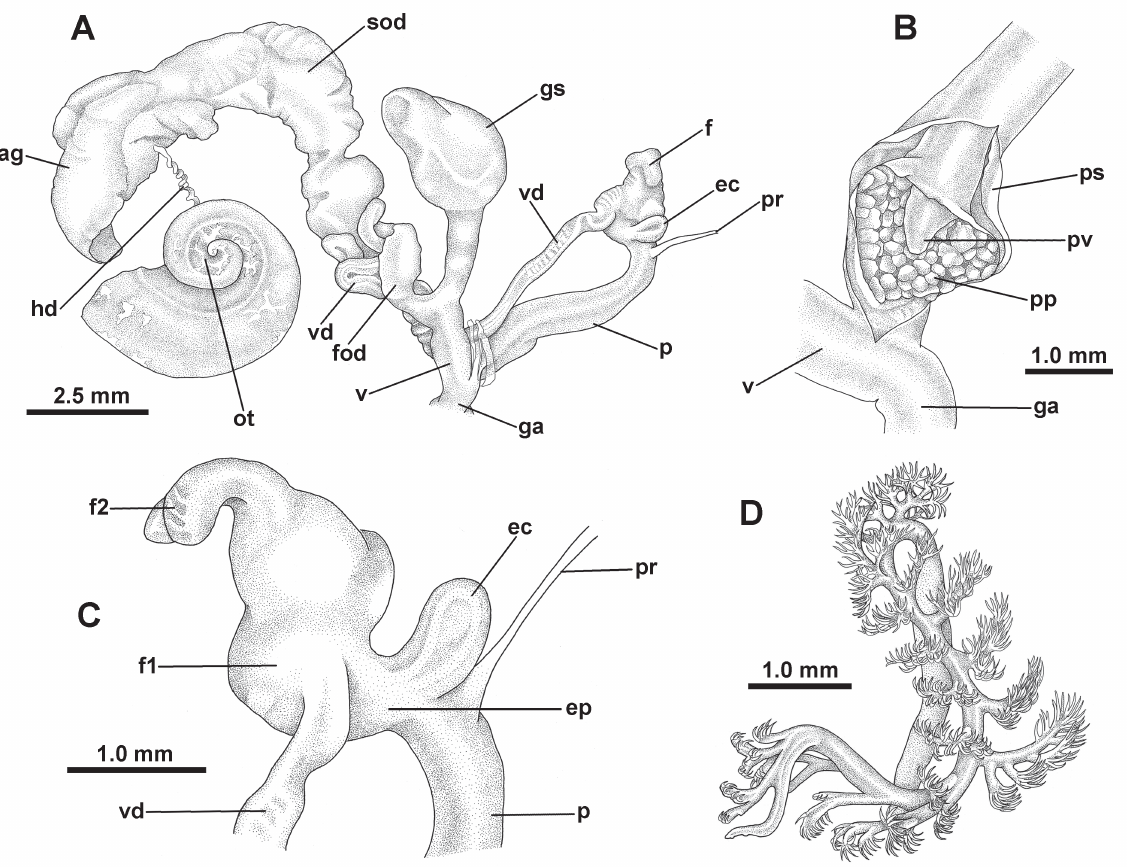
Fig. 7. Ptilototheca soutpansbergensis gen. et sp. nov., genitalia. A . Entire genital system. B . Basal portion of penis opened to show penial verge and coarsely papillate preputial region. C . Flagellum and epiphallus. D . Spermatophore. A–C. Paratype, NMSA P0304/T4060. D. Paratype, NMSA